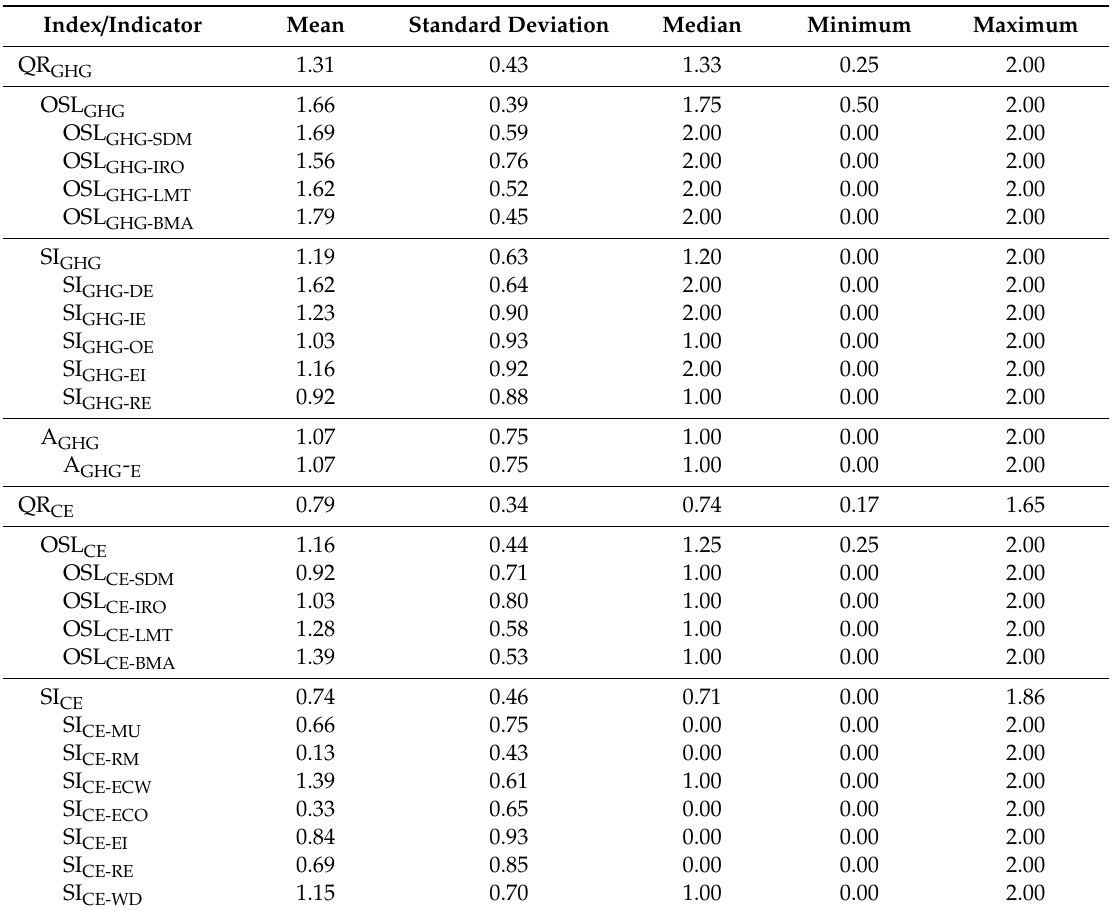
Table 3. Descriptive statistics of the indices and indicators related to the assessment criteria. Index /